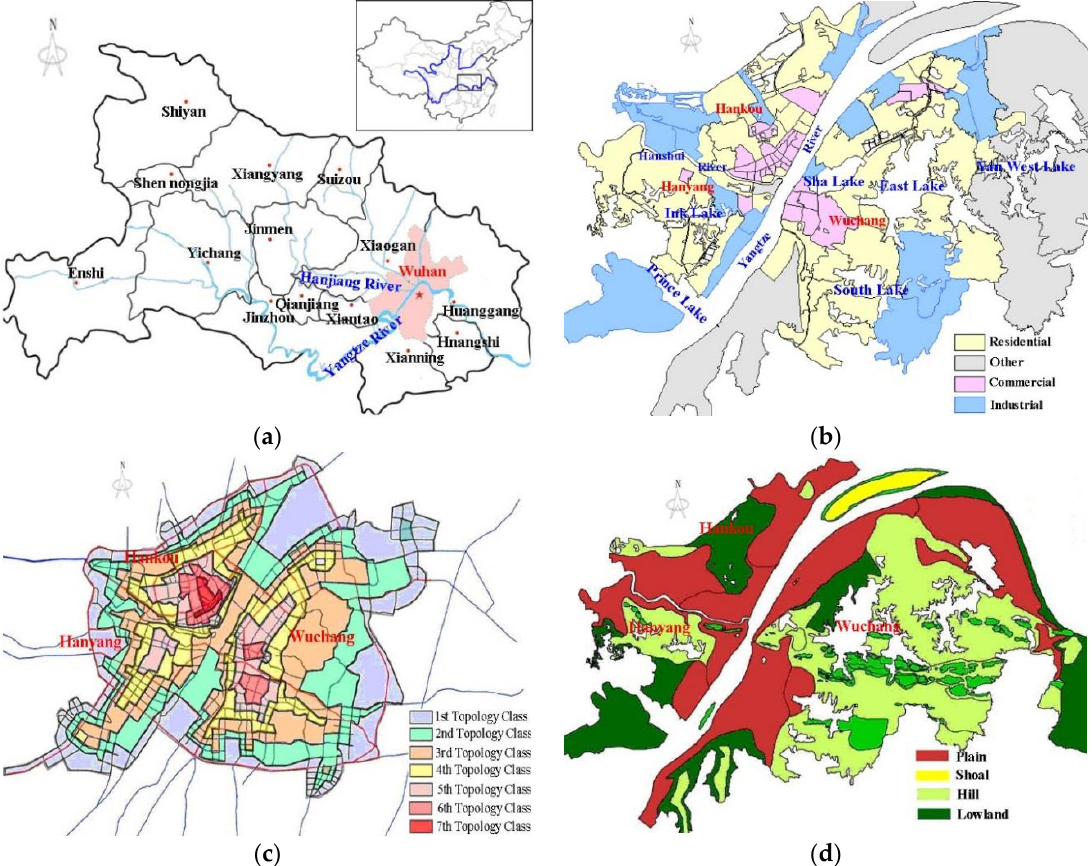
Figure 1. The spatial patterns of the study area. ( a ) Spatial location of Wuhan in the whole nation; ( b ) spatial distribution of land uses in the study area; ( c ) road network topology distribution of the study area; and ( d ) topography distribution of the study area.